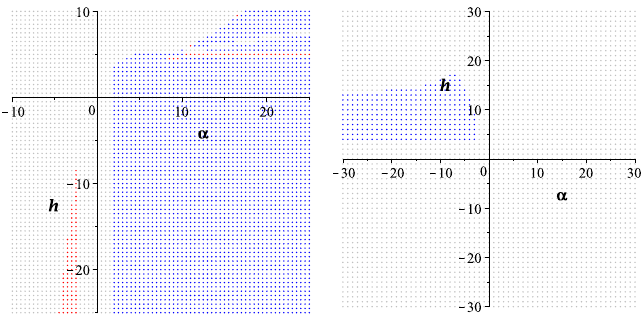
Figure 3 . Possible critical points in ( (cid:11); h ) parameter space with charge: Left : for k = 1, (cid:15) = +1 and q = 2. Right : for k = (cid:0) 1, (cid:15) = +1 and q = 2. Possible critical points satisfying entropy and pressure conditions, where red, blue, and grey points indicate two, one, and zero possible critical points, respectively. In each case, only critical points that satisfy the various physicality constraints and minimize the Gibbs free energy have been included.